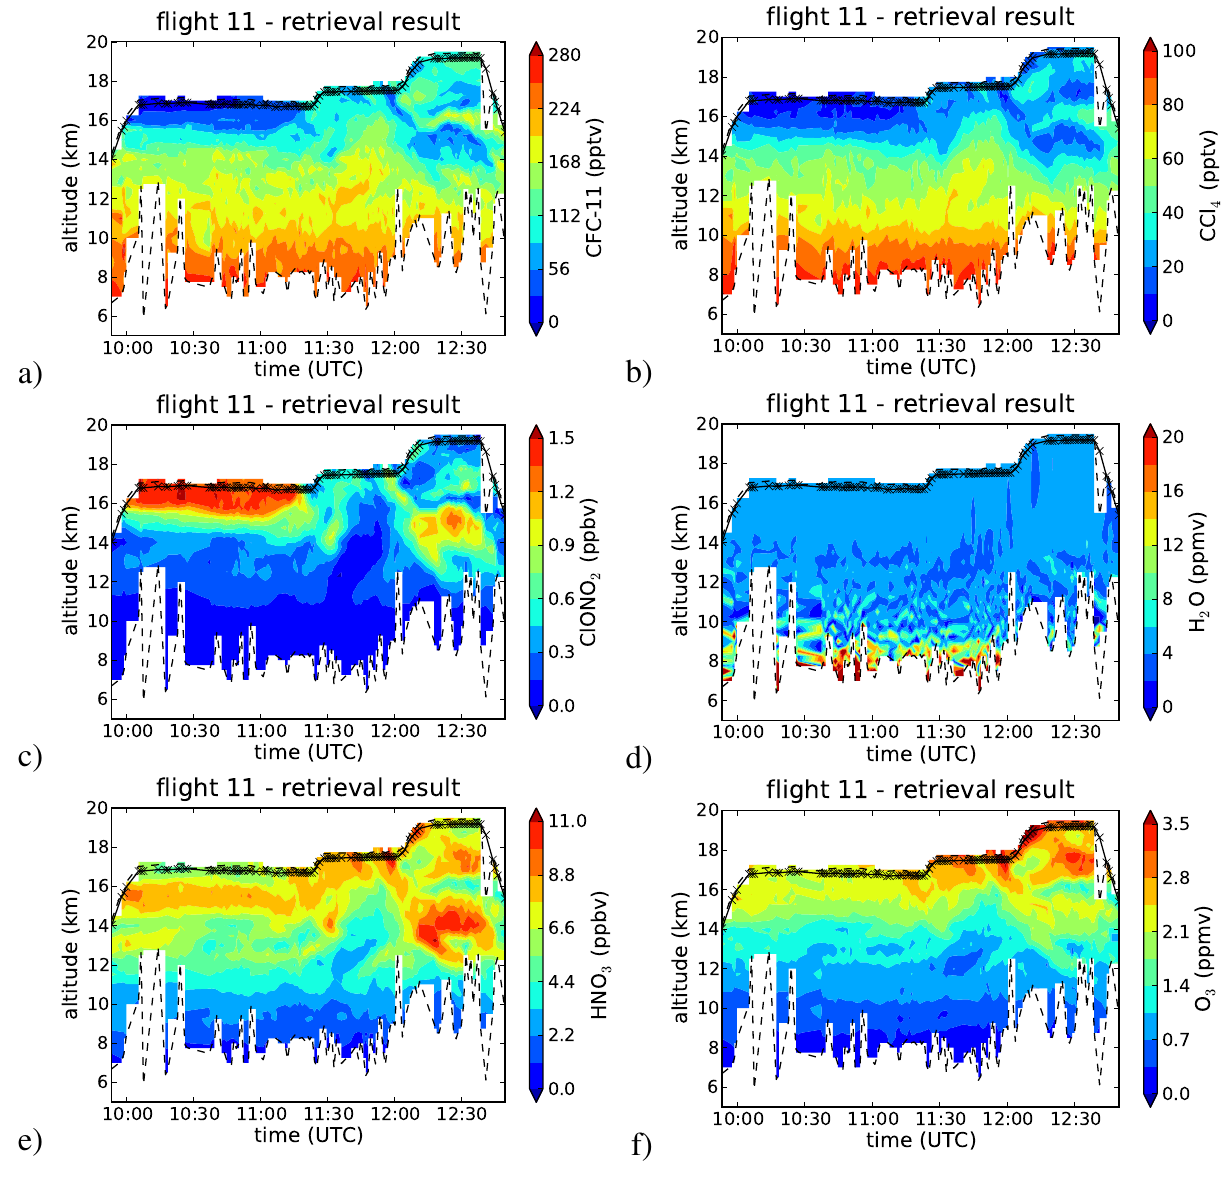
Fig. 5. Derived mixing ratio cross-sections for CCl 4 and CFC-11, ClONO 2 , H 2 O, HNO 3 and O 3 . The time, at which the profile was taken, is shown on the horizontal axis while the altitude of retrieved atmospheric quantities determines the vertical axis. The straight line indicates the observer altitude with crosses marking the position of measured profiles. Dashed lines indicate the altitude of highest and lowest valid measurement.